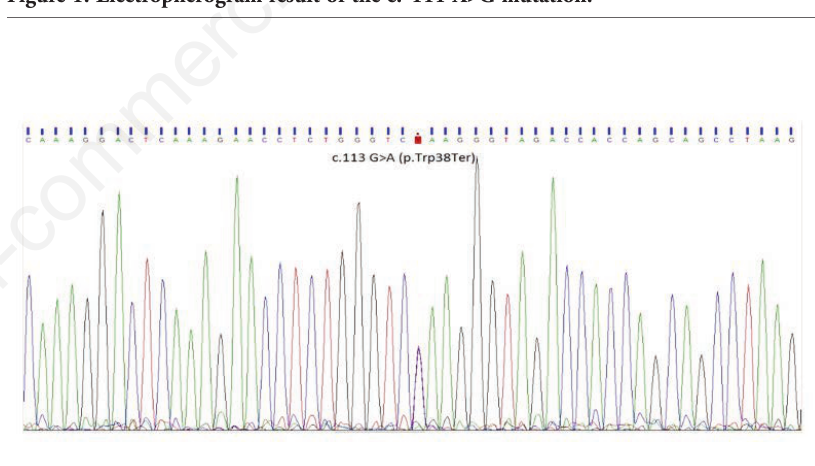
Figure 1. Electropherogram result of the c.*111 A>G